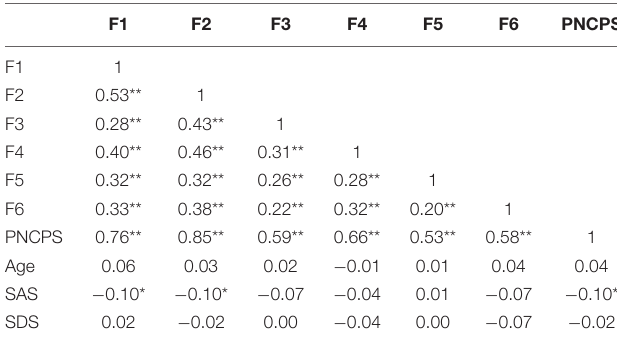
TABLE 3 | Correlations of the